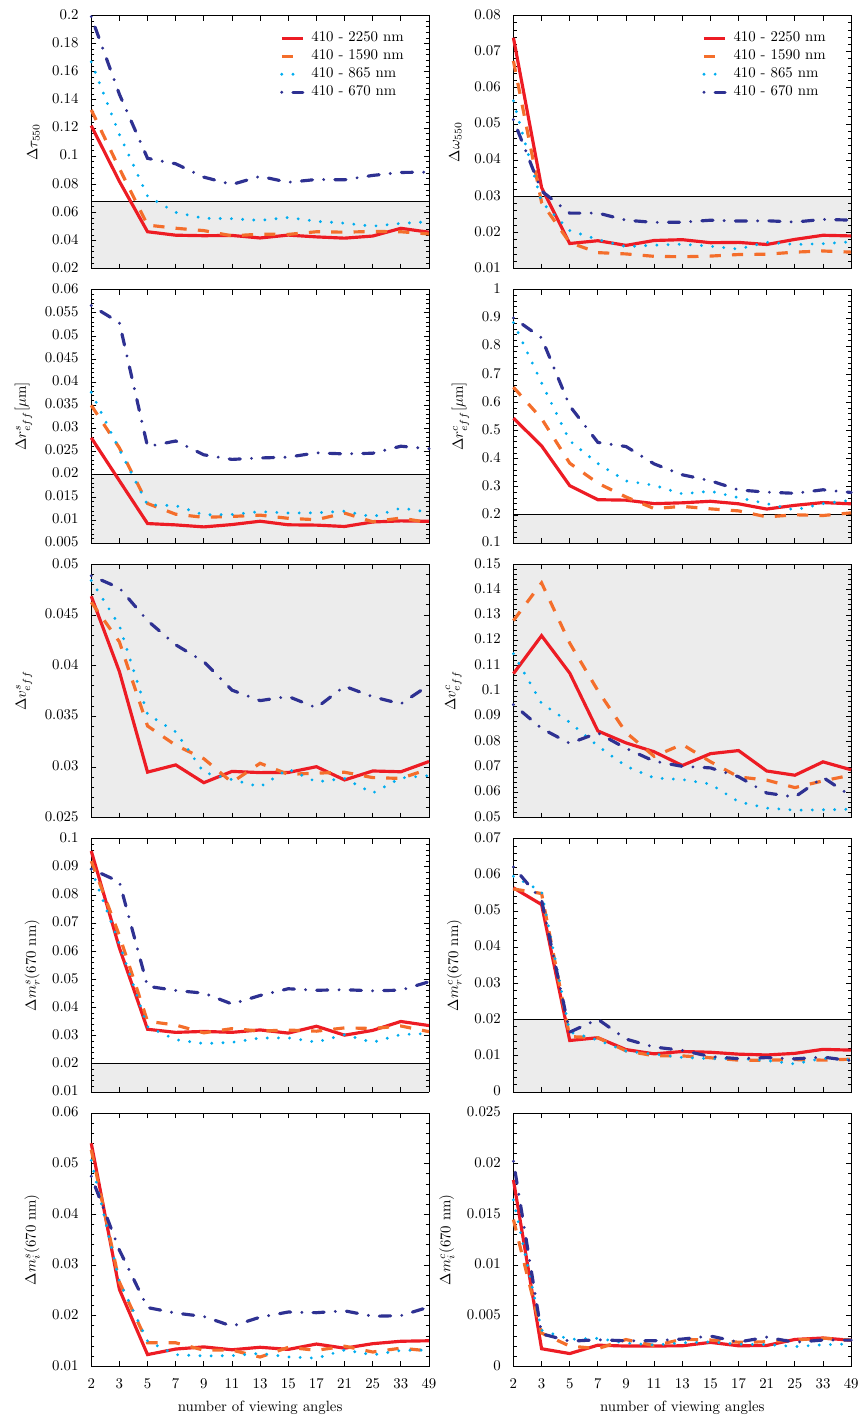
Figure 4. The results of mean absolute errors of aerosol optical depth ( τ 550 ), single scattering albedo ( ω 550 ), aerosol size parameters ( r s v s , r c and v c ) and refractive index ( m s r , m s , m c r and m c ) as a function of the number of viewing angles between retrieved and true i i eff eff eff values for four different RSP measurement configurations. Soil and vegetation surfaces are used in simulation. Aerosol types in Fig. 2 are all included in simulation and spectral variation of refractive index are included in both simulation and retrieval. The shaded areas indicate the target accuracy on aerosol parameters formulated by Mishchenko et al. (2004). For the target accuracy of AOD, we use 10% of the mean AOD, which is 0 .